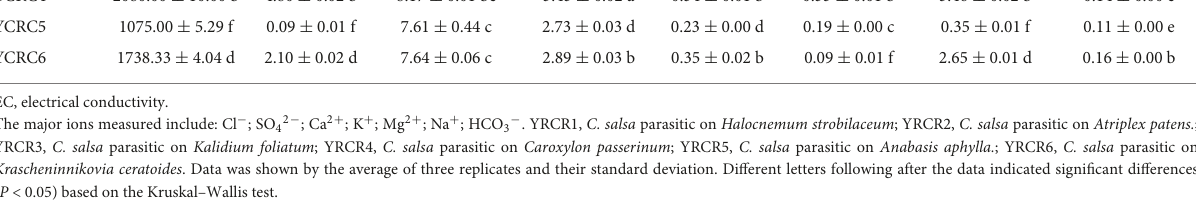
TABLE 3 Soil MBC and MBN content and CAT, UR, PHA, INV, and NR